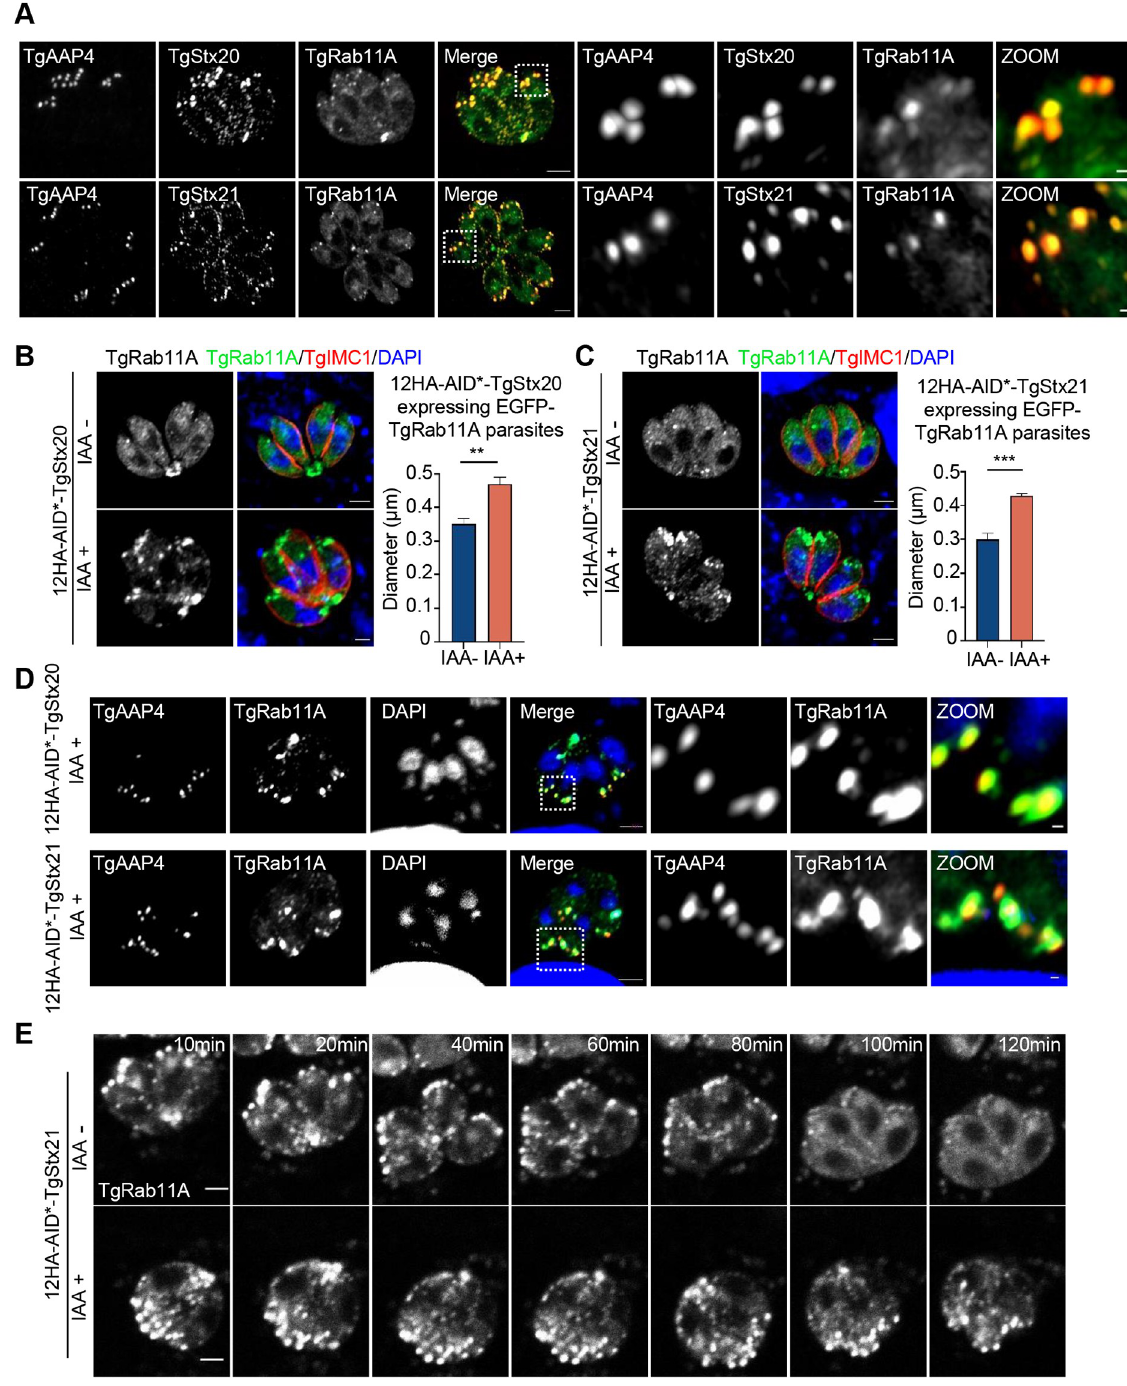
Fig 4. TgStx20 and TgStx21 partially localize to the apical annuli. (A) IFA showing that TgStx20 (orange) and TgStx21 (orange) partially colocalized with TgRab11A (green) at the apical annuli (red). A 3MYC tag was inserted at the C-terminus of endogenous TgAAP4 in 12HA-AID * -TgStx20 and 12HA-AID * -TgStx21 parasites. The parasites were transfected with a plasmid expressing FKBP-EGFP-TgRab11A, selected using pyrimethamine, and then analyzed by an IFA. Scale bars: 2 μ m (left panels) and 0.2 μ m (zoomed panels). (B) and (C) IFA showing that TgRab11A aggregated at the apical region following treatment of 12HA-AID * -TgStx20 and 12HA-AID * -TgStx21 parasites with IAA for 24 h, but was distributed in the cytoplasm without IAA treatment. The parasite cortex was stained with a rabbit anti-TgIMC1 antibody (red). Scale bars: 2 μ m. The longest diameters of the TgRab11A puncta were measured using the distance tool of ZEN 3.3 software. One hundred Rab11A-positive puncta at the apical pole were measured in each slide. Data shown in the graphs are the mean ± SEM of three